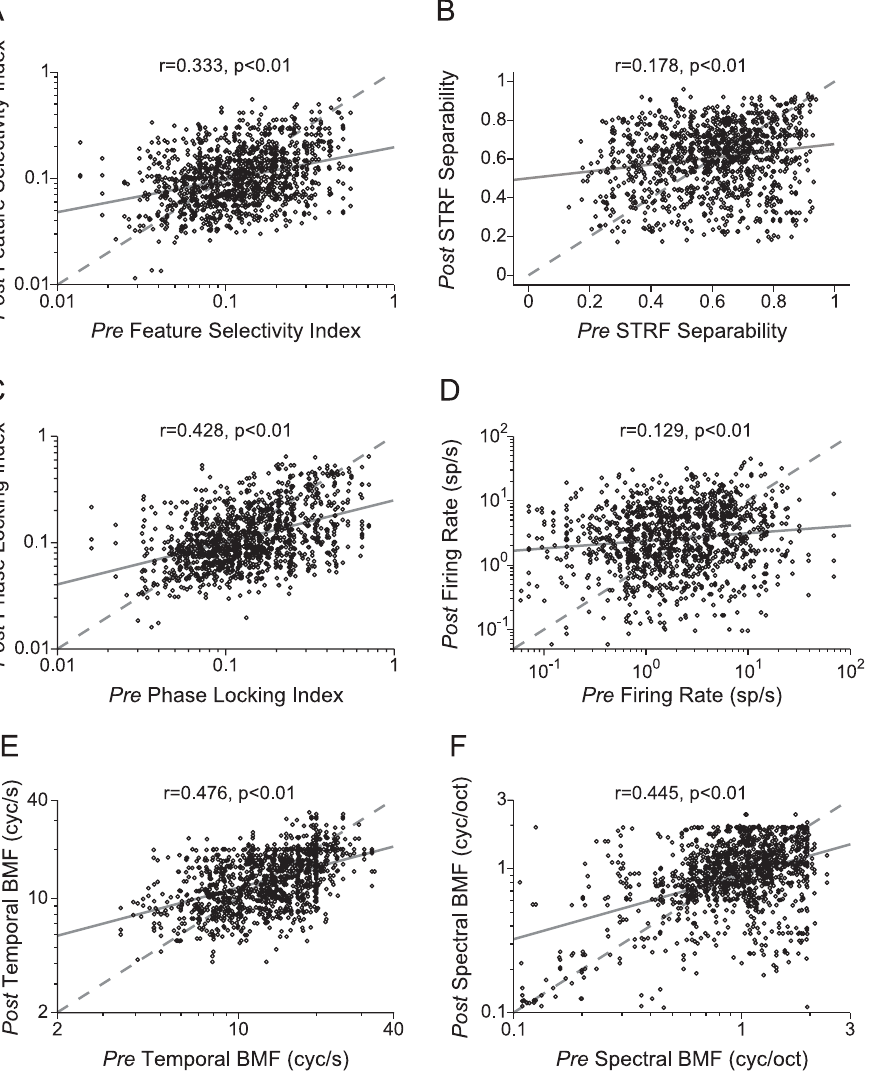
Figure 13. Comparison of receptive field parameters for monosynaptic functionally connected neurons (N=1203 pairs). Each data point represents a connected pair. The abscissa ( Pre ) represents the parameter value for the neuron in the pair that responded first, or was Presynaptic , according to the peak delay in the cross-covariance function. The ordinate ( Post ) represents the neuron whose response came after the other neuron in the pair, or was Postsynaptic . (A) Feature Selectivity Index (r=0.333, p , 0.01). (B) STRF Separability (r=0.178, p , 0.01). (C) Phase Locking Index (r=0.428, p , 0.01). (D) Firing Rate (r=0.129, p , 0.01). (E) Temporal Best Modulation Frequency (r=0.476, p , 0.01). (F) Spectral Best Modulation Frequency (r=0.445, p , 0.01; t-test used for all